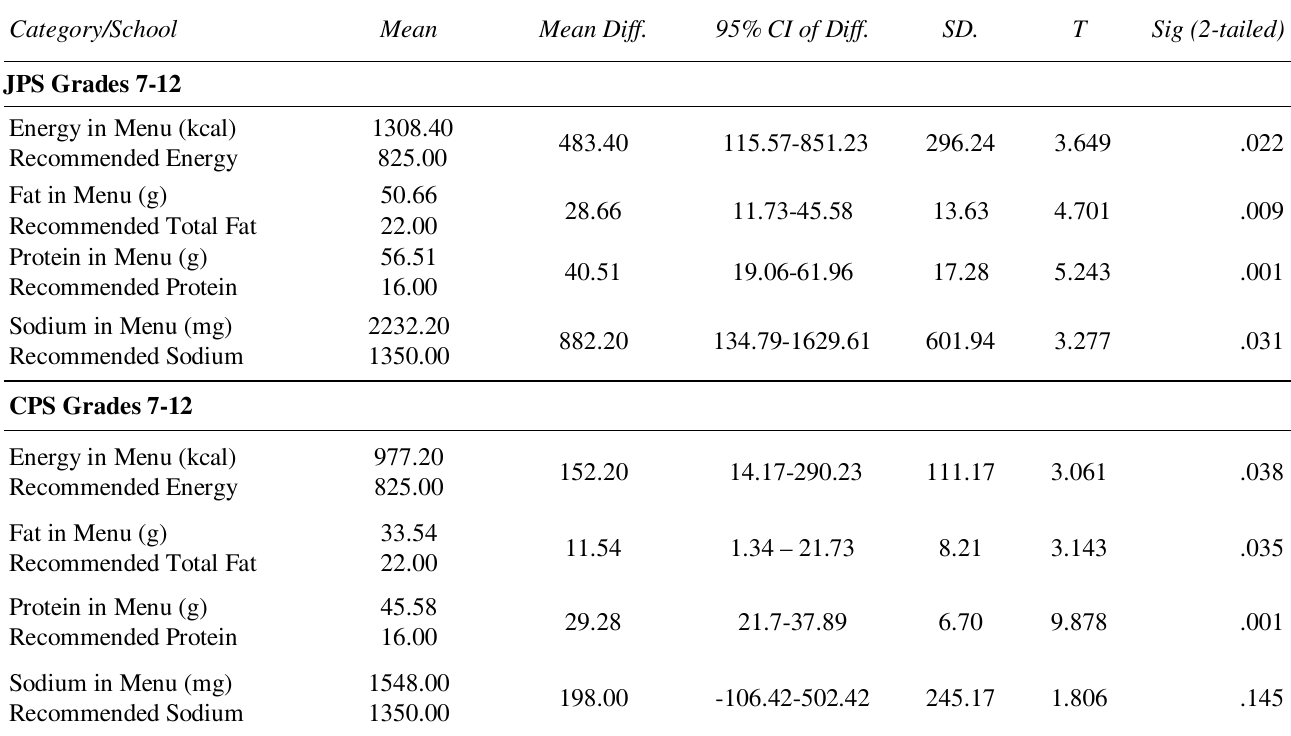
Table 10: Differences between nutrients in the regular menu and the recommended intake of nutrients for grades 7-12 Category/School Mean Mean Diff. 95% CI of Diff. SD. T Sig